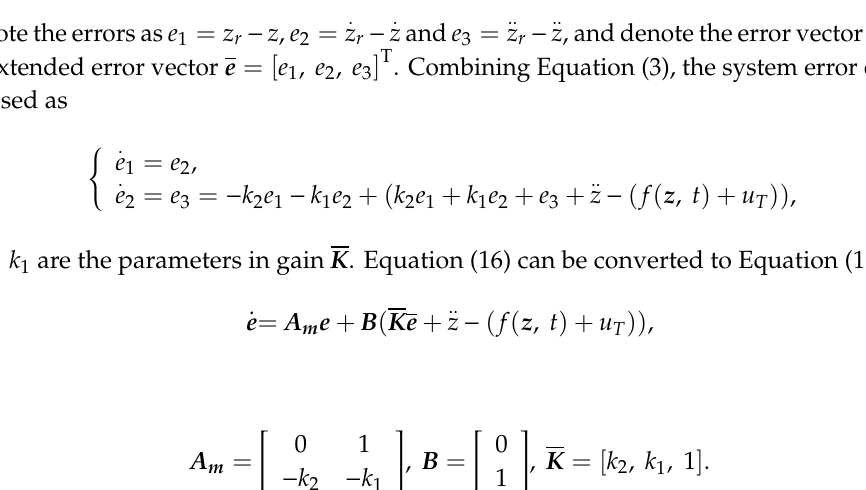
Figure 5. The block diagram of the high-order differential feedback control (HODFC) scheme.